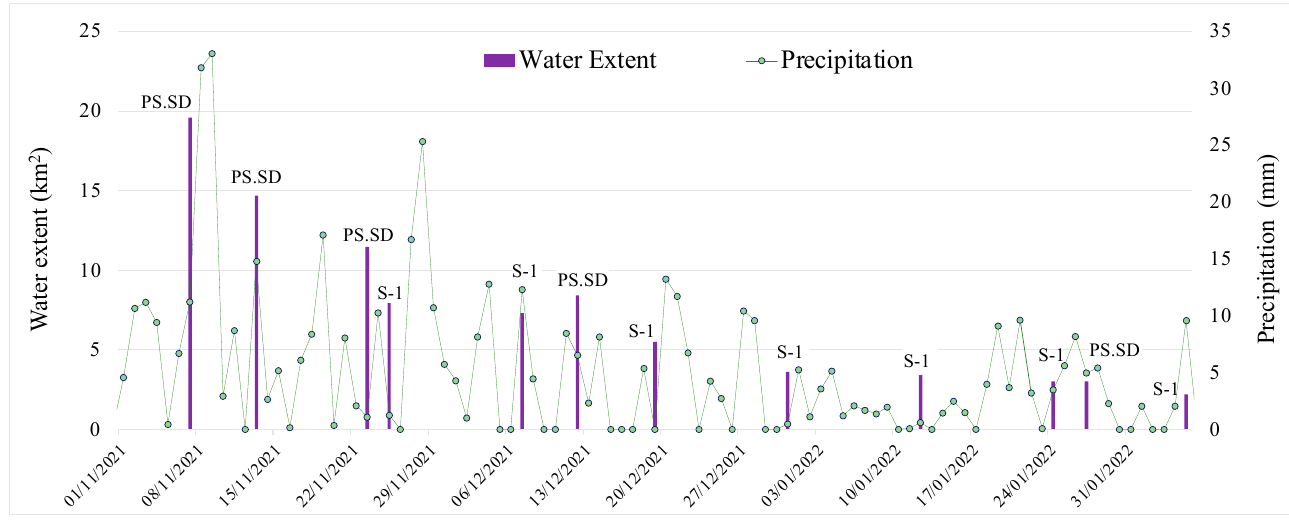
Figure 7. Potential flood-affected surface water extents after the flood on 6 November 2021 and the precipitation amount.